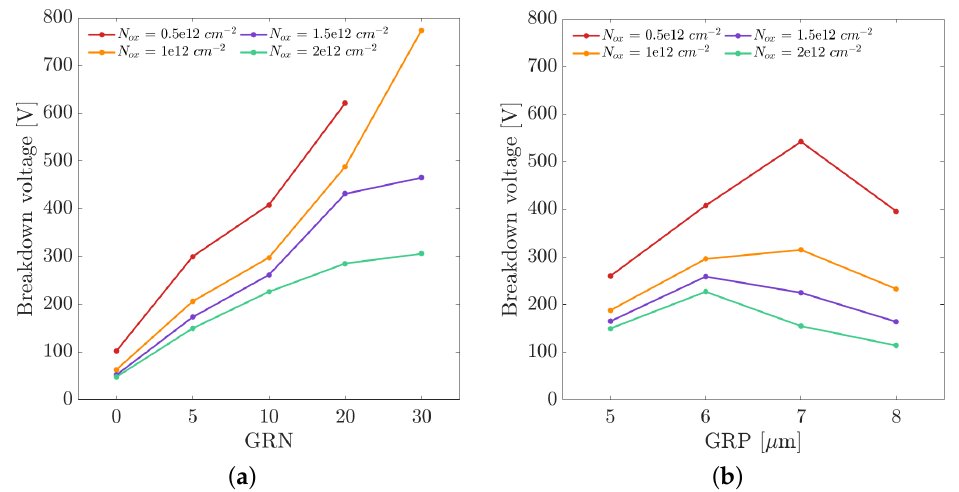
Figure 3. ( a ) Breakdown voltage as a function of the number of guard rings (GRN) for different concentrations of charges in the passivation layer ( N ox ). The results refer to simulations with guard ring pitch equal to 6 µ m. ( b ) Breakdown voltage as a function of the guard ring pitch (GRP) for different concentrations of charges in the passivation layer ( N ox ). The results refer to simulations with 10 guard rings.